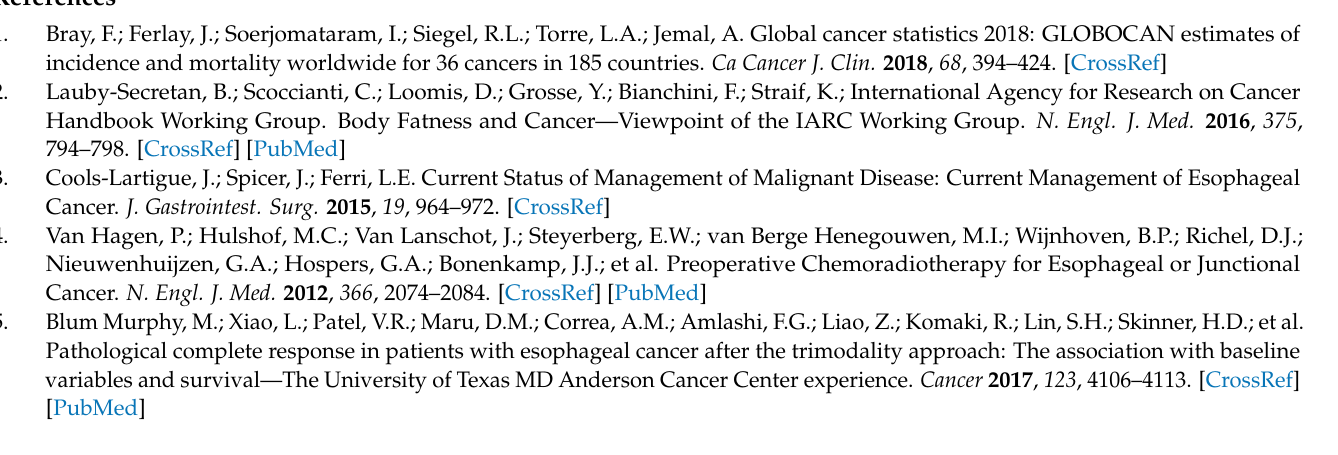
Table S1: Changes in body composition from time of diagnosis to surgery, Table S2: Patient Charac-